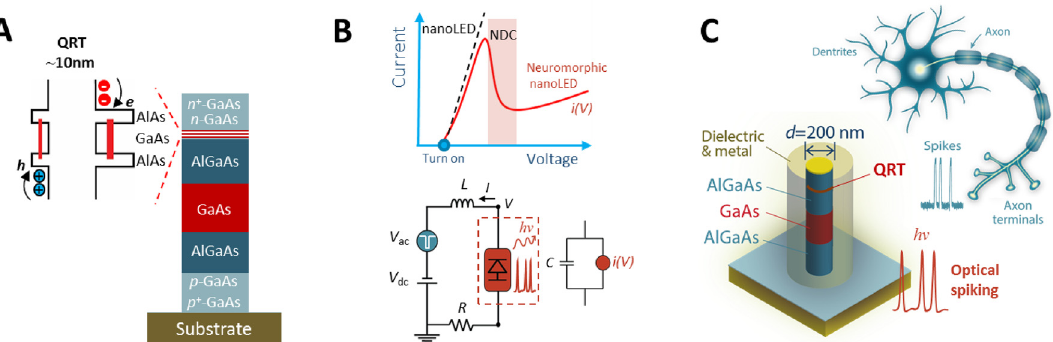
Figure 1: General description of the sub- λ nanophotonic neuron. A Schematic of the semiconductor epitaxial heterostructure (not to scale). It is formed bya QRT nanostructure monolithicintegrated ina AlGaAs/GaAs/AlGaAs light-emitting diodeepitaxial heterostrucuture. In theinset is shown the 10-nm thick QRT AlAs/GaAs/AlAs nanostructure in the n + n n + section. B (Top panel) Comparison of the I - V curves between a standard nanoLED (dashed line) and a neuromorphic nanoLED (solid red line). The neuromorphic nanoLED features an i ( V ) with a voltage- controlled NDC. (Lower panel)Schematicof the circuit. The diode is modeledby a nonlinear voltage-controlled current source, i ( V ), in parallel with the equivalent capacitance, C . The resistance, R , and inductance, L , are the equivalent lumped elements of the LED and electrical connections. The circuit includes a DC voltage source, V dc , and a voltage time-dependent signal, V ac , for synaptic-like activation of the all-or- nothing spiking response. C Schematic of the sub- λ nanophotonic neuron in a 200 nm cross section nanopillar using a metal-dielectric con fi guration. Inset on top is shown the schematic representation of a biological